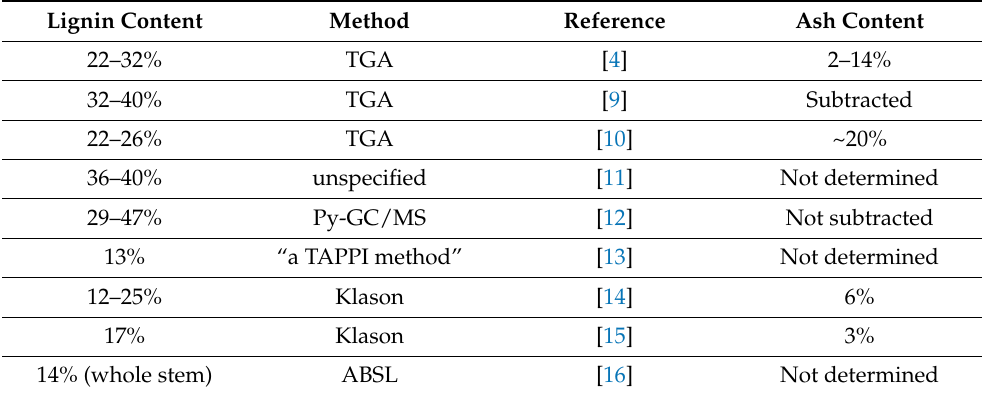
Table 1. Comparison of lignin content of papyrus sheets (or stems) reported in the literature. Lignin Content Method Reference Ash Content 22–32%